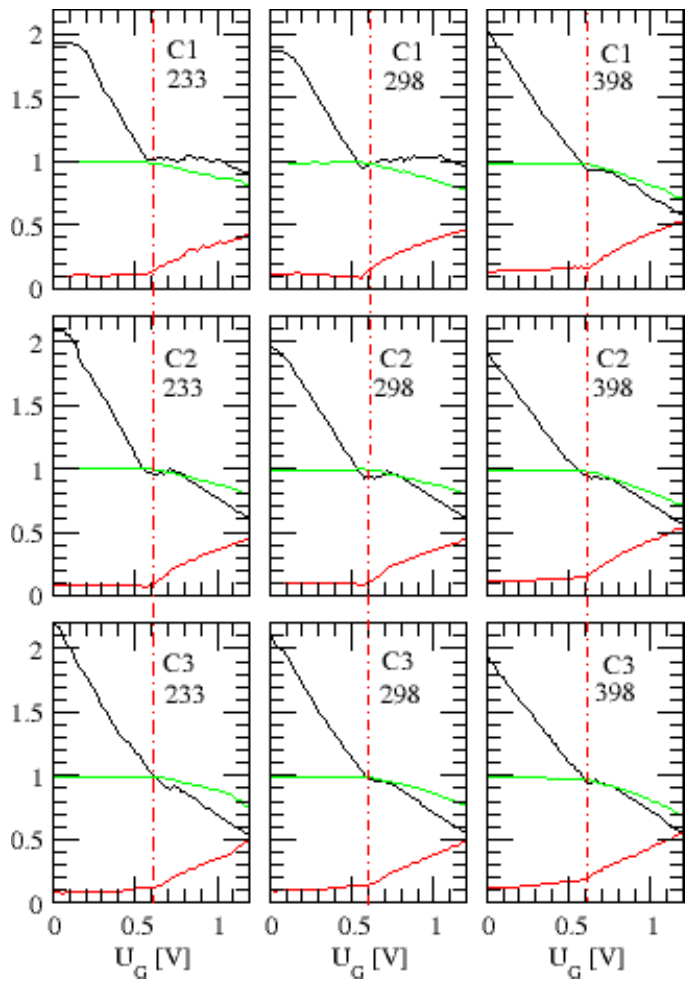
Figure 4. The calibration functions for barrier height v 0 ( U G ) (black) and for the device temperature u ( U G ) (red) and the normalized chemical potential in the source m ( U G ) (green). Upper row C1, middle row C2 and lower row C3; left column environment temperature T = 233 K, middle column T = 298 K and right column T = 398 K. The threshold voltage U th is marked with a red dash-dotted vertical